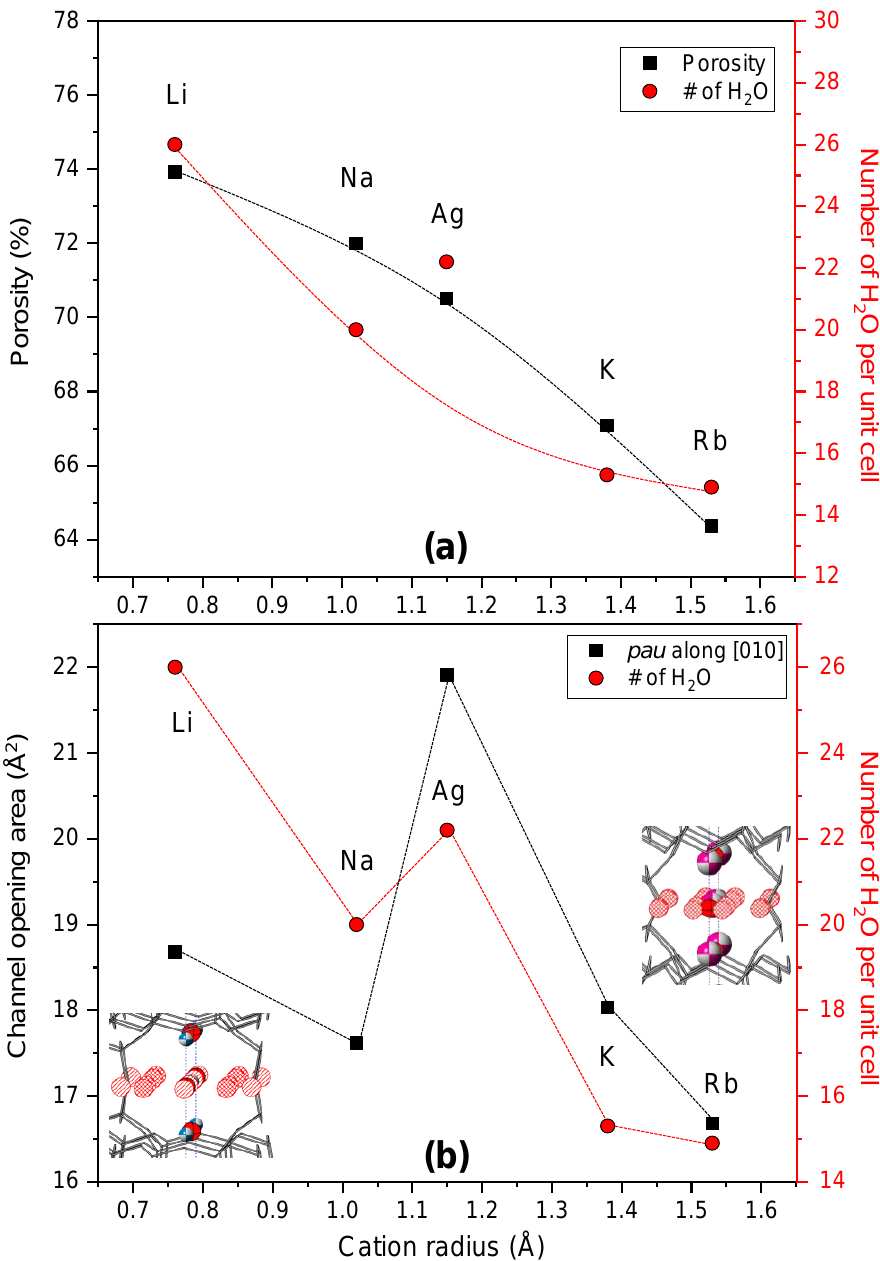
Figure 5. Changes of ( a ) porosity and amount of water molecules and ( b ) channel opening area of the pau unit and amount of water molecules as a function of extra-framework cation size.